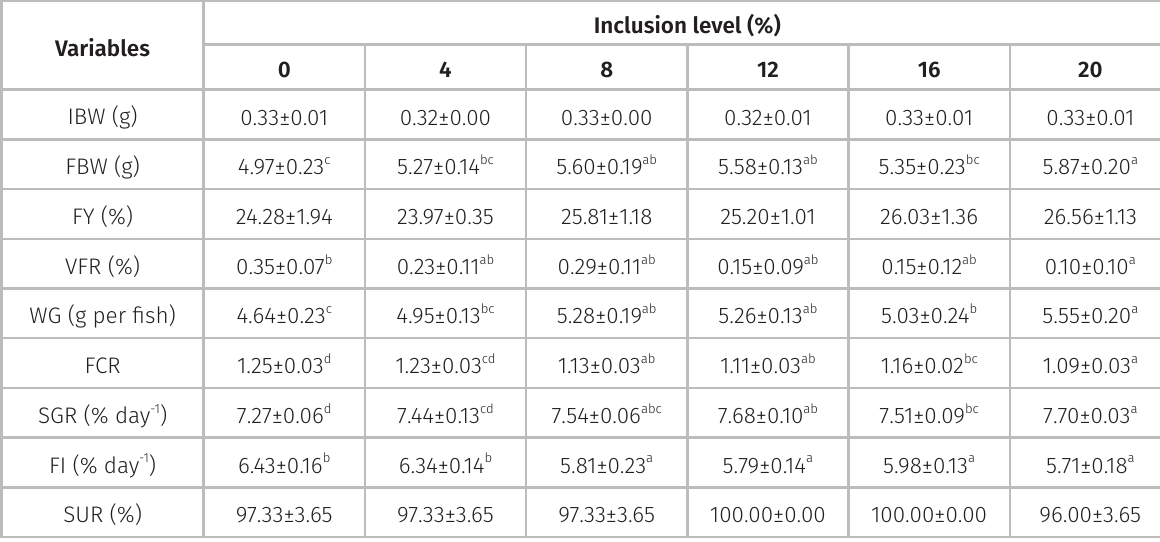
Table II. Production responses of Nile tilapia (Oreochromis niloticus ) fingerlings fed diets containing different levels of crude glycerin